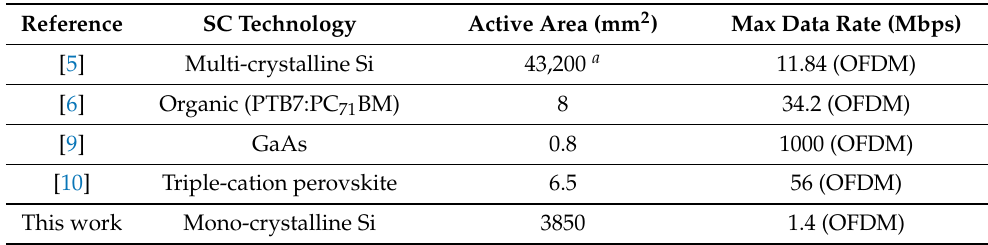
Table 3. Comparison between data rates in SLIPT-based demonstrations in the